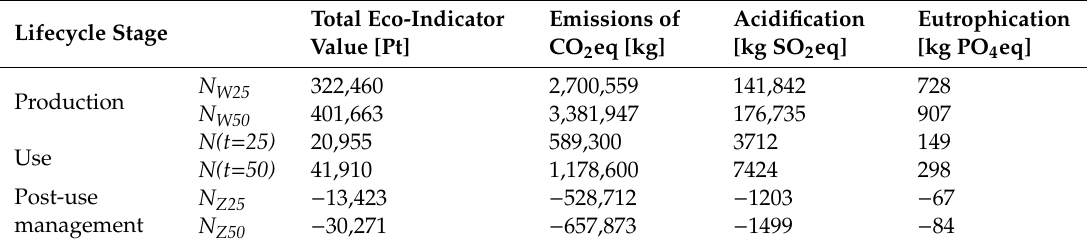
Table 4. Ecological costs determined with the aid of the LCA method in the material stages of a 25 years and 50-year lifecycle of a wind power plant (the Eco-indicator 99 method).